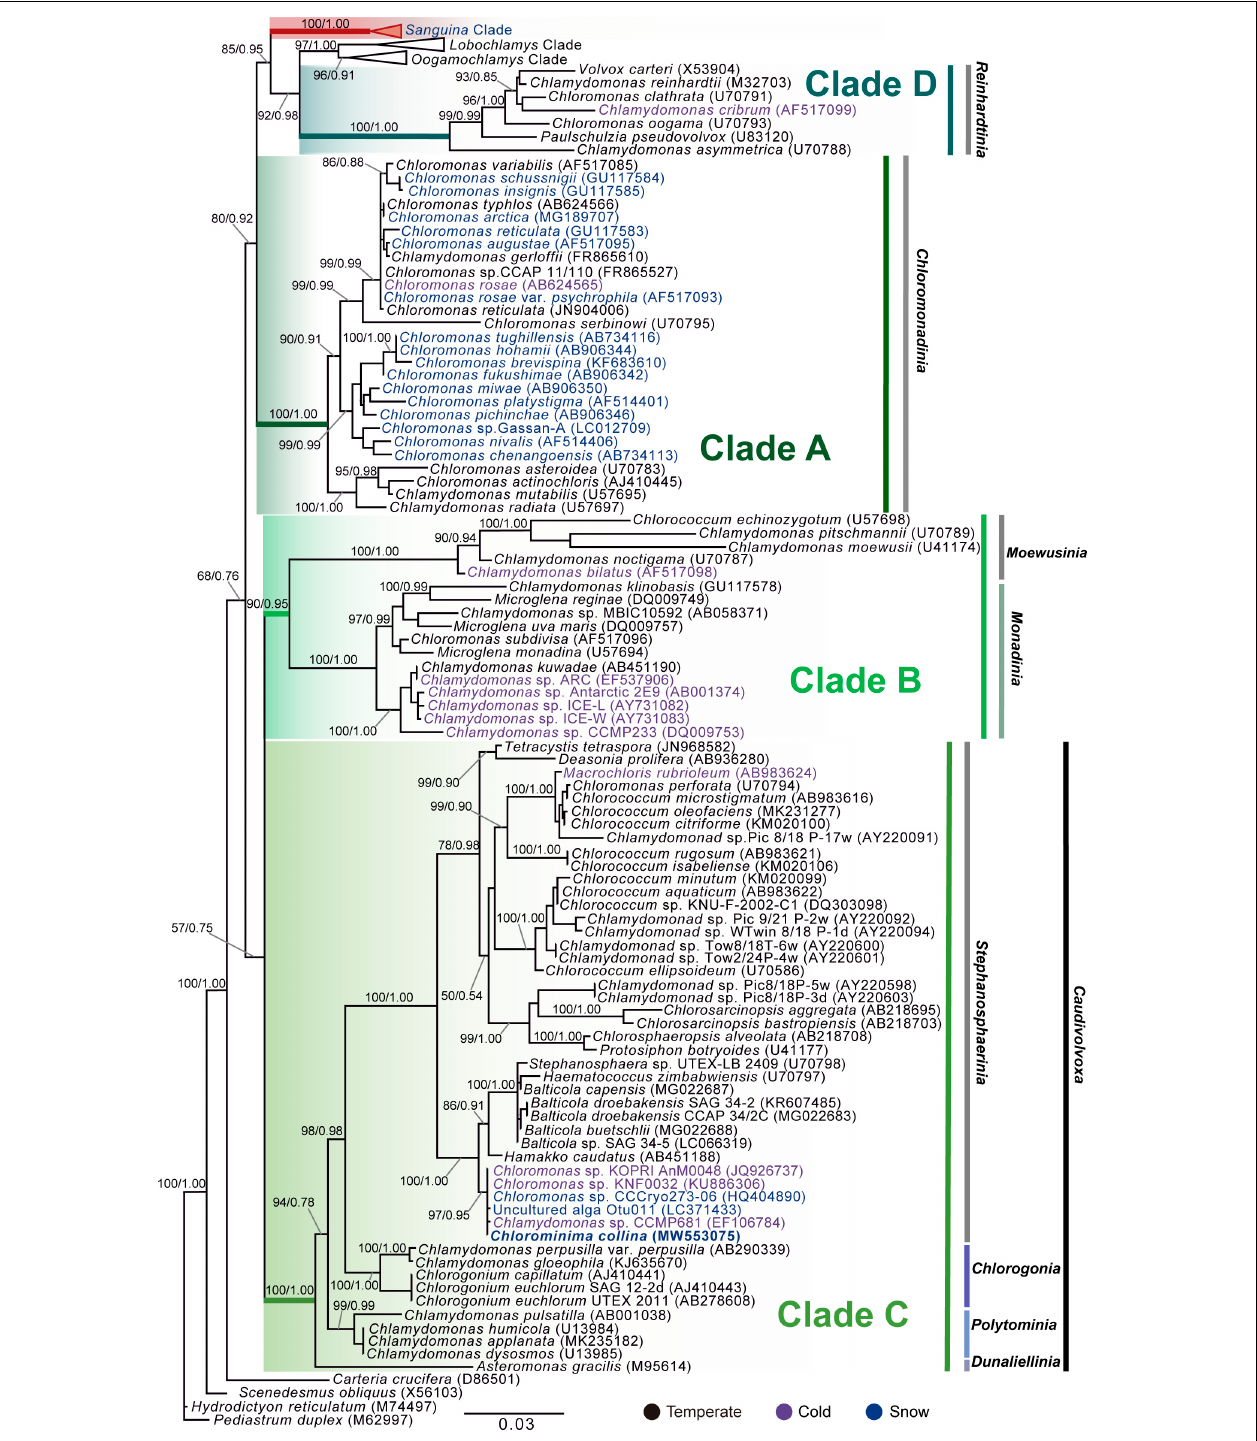
FIGURE 5 | Maximum-likelihood phylogram of the sequences of the 18S rRNA gene of Chlorominima collina CCAP 6/1 and other representative members of the order Chlamydomonadales. Clades A, B, C, and D were circumscribed according to Buchheim et al. (1997) and Hoham et al. (2002). The new genus of Sanguina snow algae is specified (Procházková et al., 2019a). Carteria crucifera , Tetradesmus obliquus , Hydrodictyon reticulatum , and Pediastrum duplex were considered as outgroup. The names of the clades were designated according to Nakada et al. (2008). The numbers on the branches indicate statistical support values (Maximum-likelihood bootstraps/Bayesian posterior probabilities). Snow taxa are marked in blue, taxa from other cold environments, not from snow, are marked in purple and the rest of the taxa from other temperate environments are written in black. The lower bar indicates changes by nucleotide position (0.03).